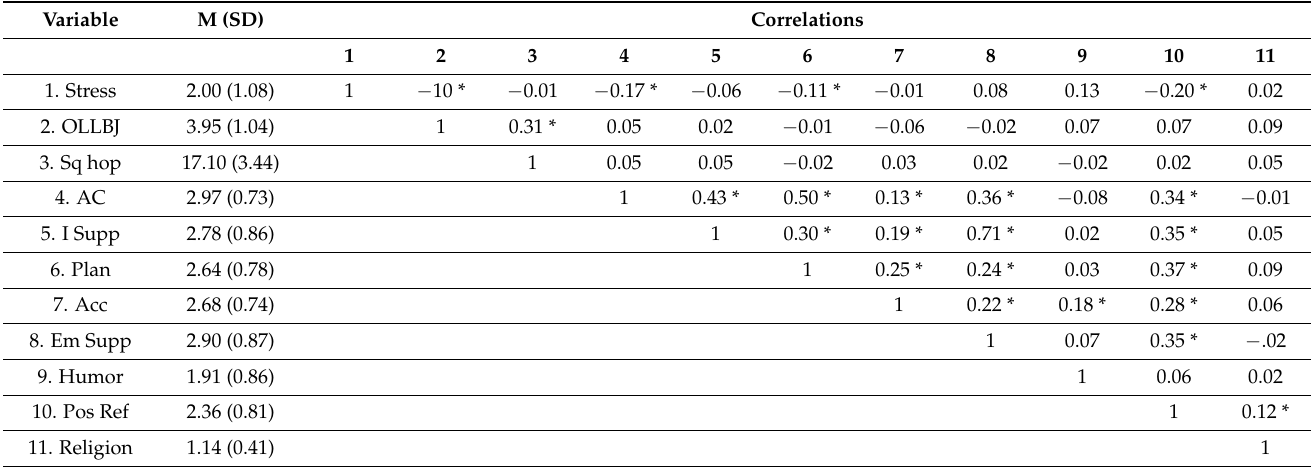
Table 2. Results of the descriptive analysis of the independent variables (stress, functional tests, and coping